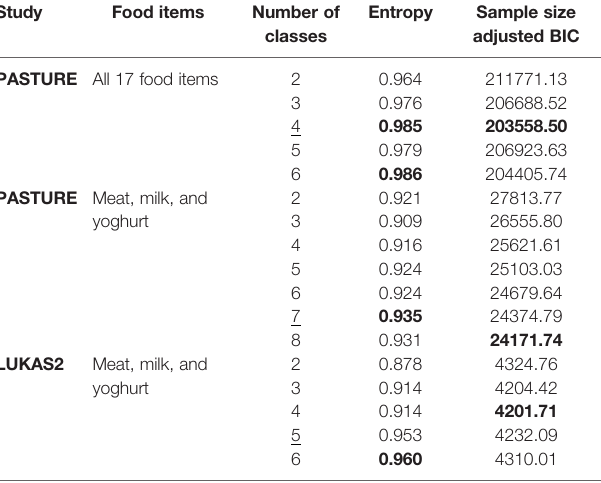
TABLE 1 | Model fi t criteria of the latent class